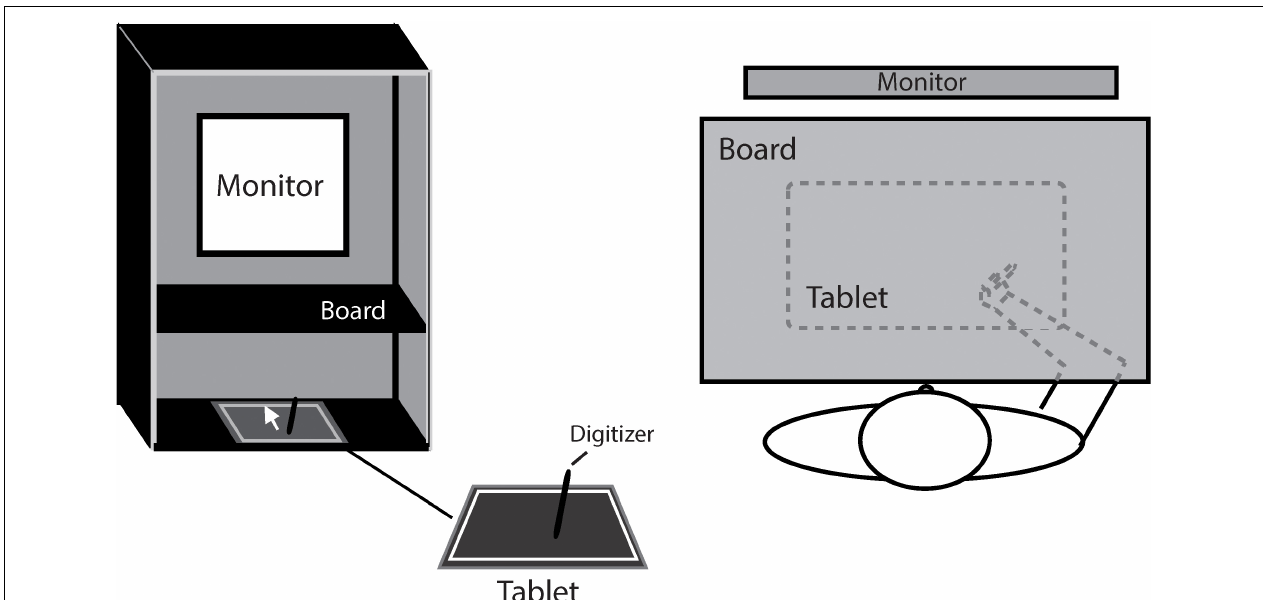
FIGURE 1 | The illustration of experiment